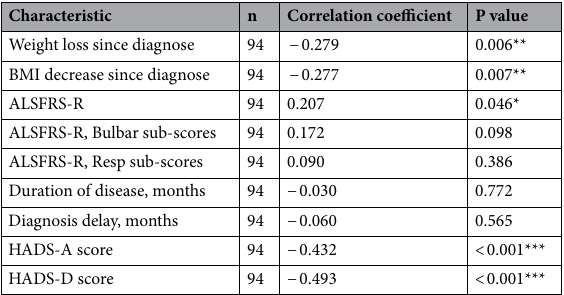
Table 4. Correlations between CNAQ scores and baseline disease characteristics. ALS amyotrophic lateral sclerosis, ALSFRS-R ALS Functional Rating Scale-Revised, BMI body mass index, HADS-A Hospital Anxiety and Depression Scale-Axiety, HADS-D Hospital Anxiety and Depression Scale-Depression. *p < 0.05; **p < 0.01; ***p < 0.001.